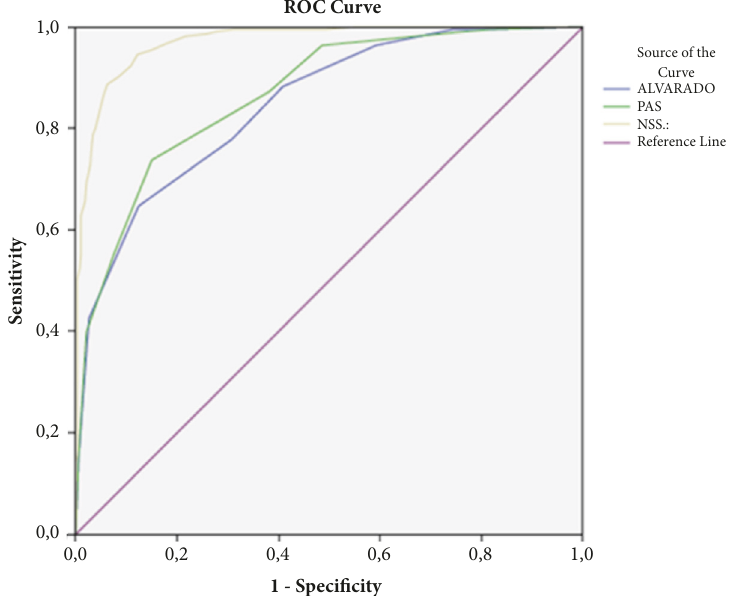
Figure 3: ROC curvesfor the overall performances of PAS, ASS, and NSS (AUC=0.868 CI=0.839-0.897, and p ≤ 0.001)(AUC=0.847, CI=0.816- 0.878, and p ≤ 0.001) (AUC=0.972, CI=0.960-0.983, and p ≤ 0.001),